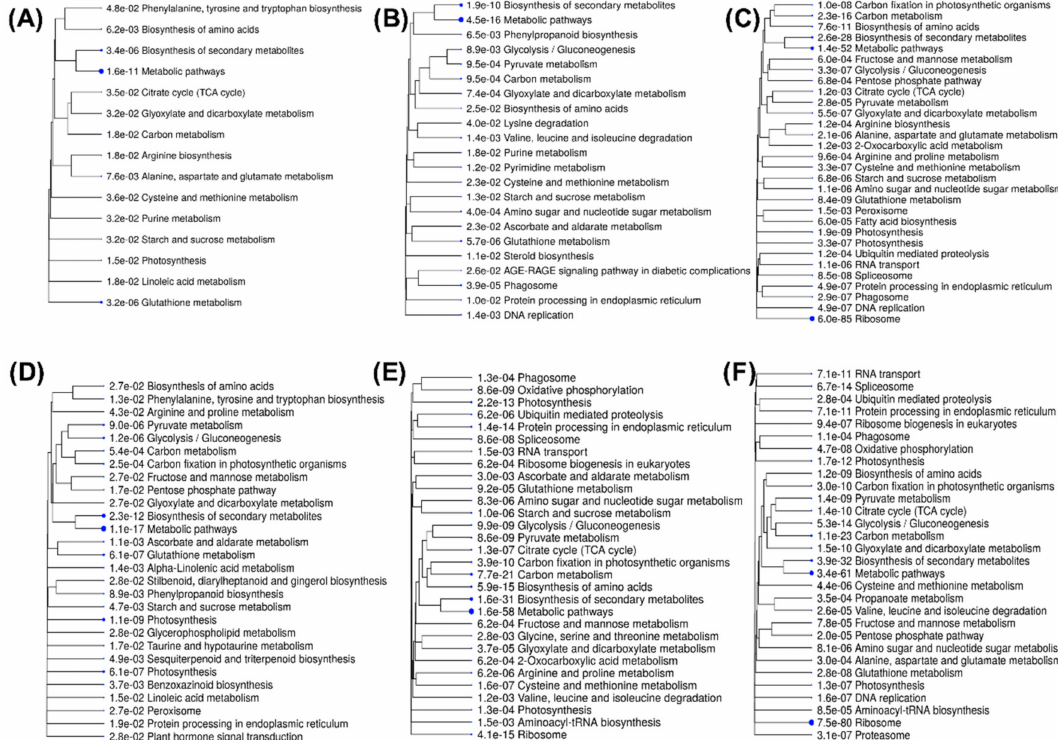
Figure 6. The clustering of KEGG-enriched functional categories of DEGs in the root and shoot under Fe and Zn stresses: ( A ) –Zn in root; ( B ) –Fe in root; ( C ) –Fe–Zn in the root; ( D ). –Zn in the shoot; ( E ) –Fe in shoot; and ( F ) –Fe–Zn in